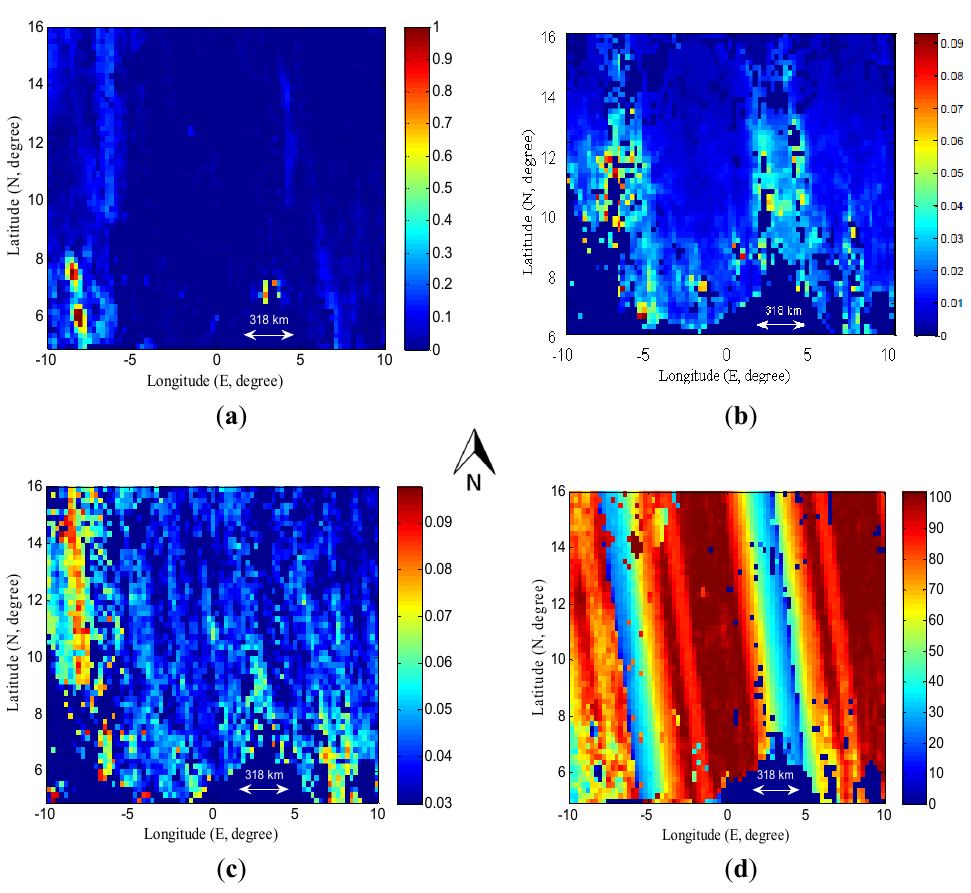
Figure 6. Quality control flags: ( a ) RFI fraction ((RFI x + RFI y )/M_AVA0); ( b ) soil moisture DQX; ( c ) Chi-square; ( d ) M_AVA.